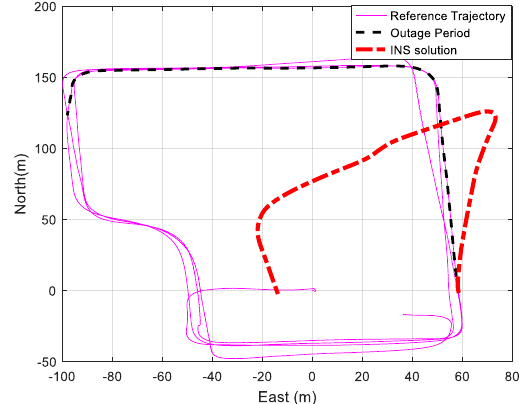
Figure 21. Second Trajectory INS standalone navigation solution for 60 seconds GNSS signal outage